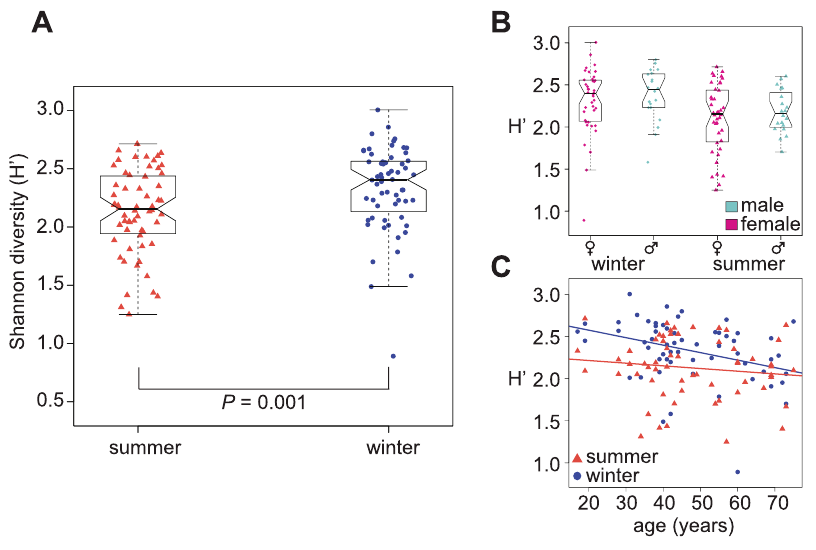
Figure 4. Diversity between seasons, sexes, and age. A) A significant difference (paired t-test P , 0.002) in Shannon diversity (H 9 , y-axis), between season (x-axis). B) H 9 between sexes is not significantly different in either winter (t-test P =0.46) or summer ( P =0.38). C) Diversity significantly decreases with age based on the data collected from winter samples (r 2 =0.1267, P , 0.006), but not based on the data collected from the summer samples (r 2 =0.01653, P =0.33).